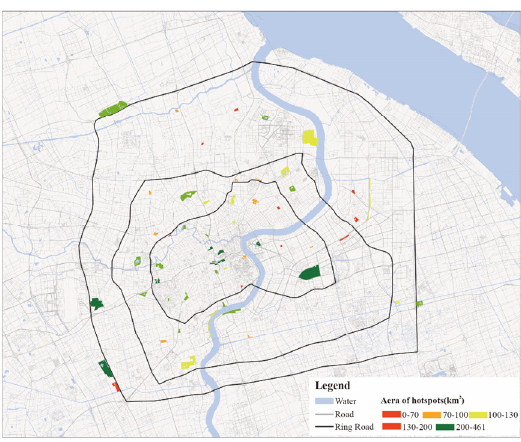
Figure 4. Spatial distribution of parks with different hotspot areas. Table 3. The average hotspot areas of park visitors’ residences for different categories of parks. Average Area of Hotspots of Park Visitors’ Location Residences (km 2